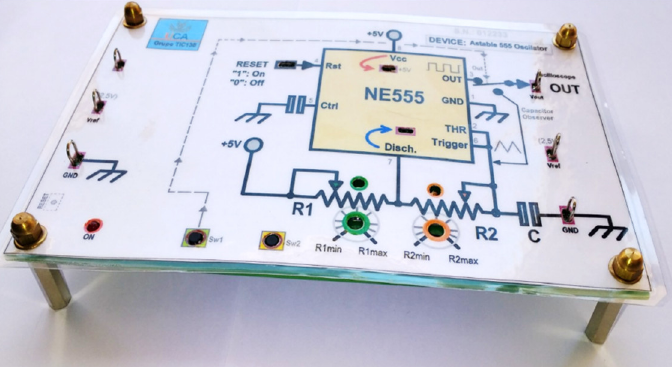
Figure 1. A picture of the emulator proposed. In this case, the “dummy” shows a cover-illustration (interchangeable) to emulate the classical 555-IC oscillator circuit.